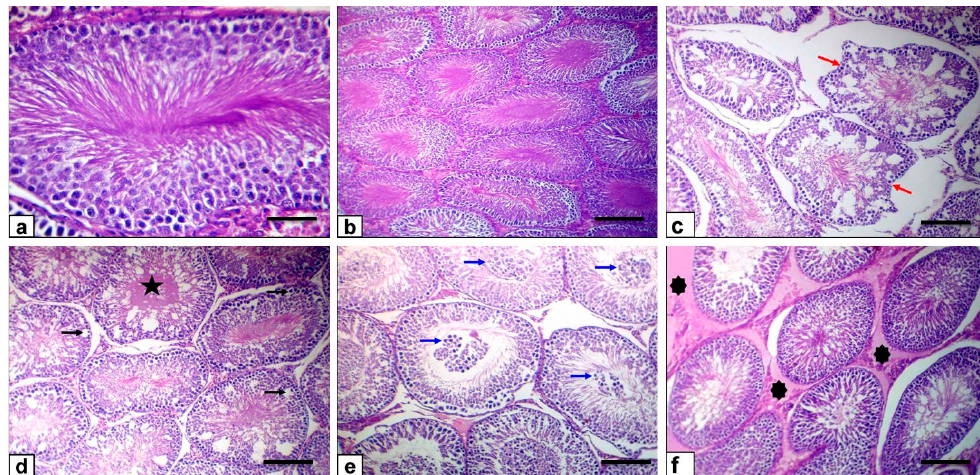
Figure 8. Photomicrograph of rat testes stained with HE: ( a ) the normal teste histoarchitecture of the control rats (scale bar = 50 μ m); ( b ) ZnONP-1 rats showing normal seminiferous tubules with normal spermatogenesis (scale bar = 100 μ m). ( c – f ) ZnONP-2 rats were showing shrunken, buckled, disorganized (red arrows) seminiferous tubules, depletion of germinal cells and hyalinization of the luminal contents (star), vacuolation (black arrows), and sloughing of the germinal epithelium in the lumen of the seminiferous tubules (blue arrows); this besides interstitial edema (asterisks), which is represented by the faint eosinophilic albuminous material (scale bars = 100 μ m).